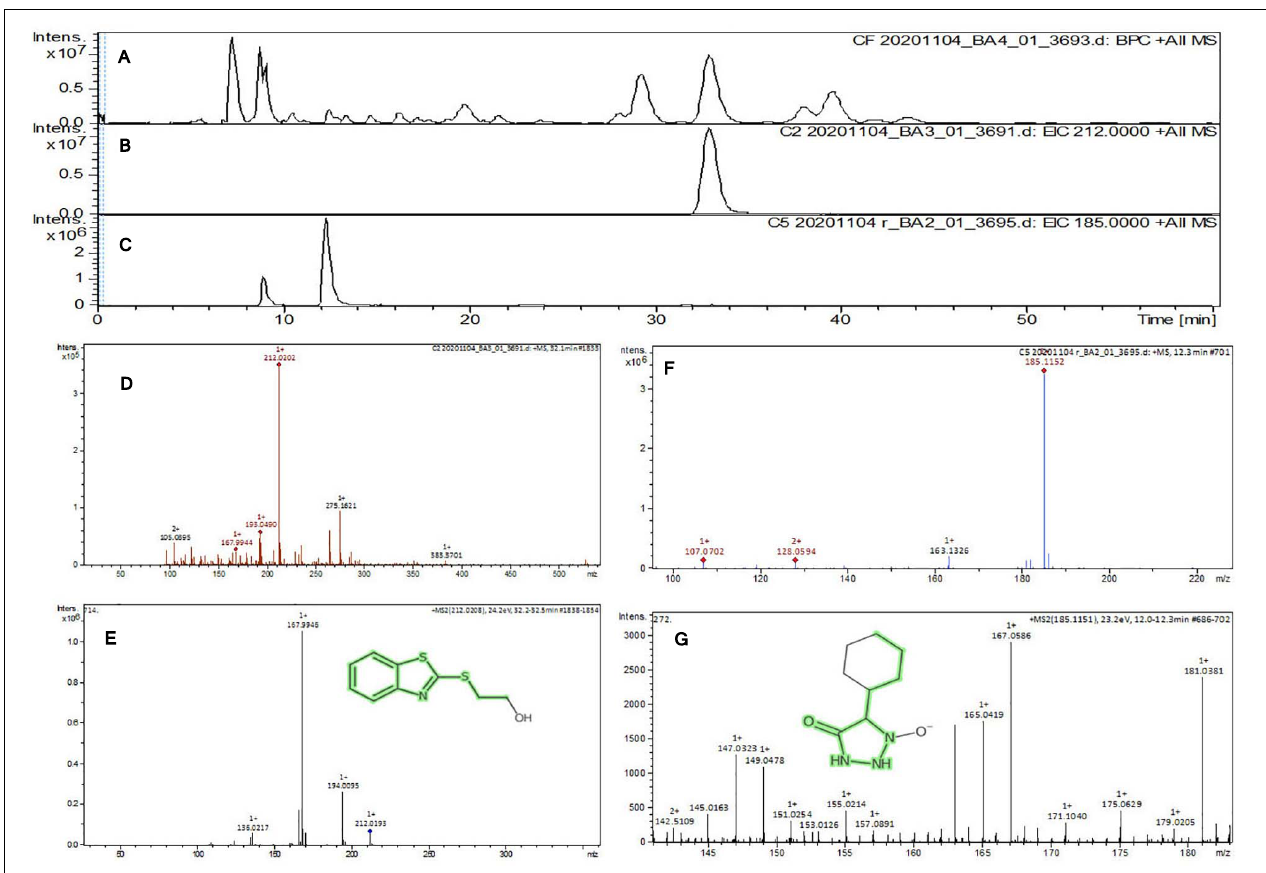
FIGURE 11 | Liquid chromatogram profile from culture filtrate extract of B. petrensis (A) , liquid chromatogram profile of purified C2 fraction (B) , and C5 fraction (C) . The LC peak at Rt 33.31 and 10.13 displaying the purified bioactive fractions C2 and C5 corresponding to fungal culture filtrate extract Rt 33.31 and 10.14, respectively (A–C) . The mass spectrum displaying the feature m/z 212.02, 185.11 [M+H] + of compounds 2-(1,3-benzothiazol-2-ylsulfanyl)ethanol and 5-cyclohexyl-1-oxido-triazolidin-4-one obtained a similar characteristic feature of molecular mass in CFE with a positive ion mode (D–G)